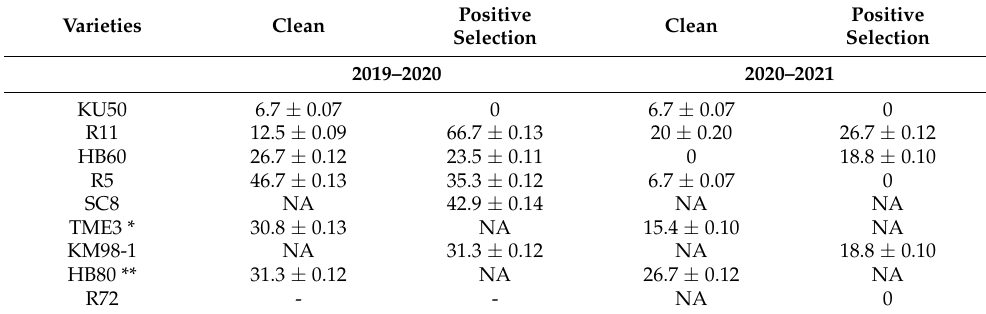
Table 4. Percentage of asymptomatic plants testing positive for Sri Lanka cassava mosaic virus (SLCMV) over 2 years. Young leaves from 33.3% of plants without any symptoms from each plot were collected for diagnosis of SLCMV by PCR of 9 varieties of cassava listed. Samples were collected 63 and 270 days after planting (DAP) during 2019–2020 season (year 2) and 21 DAP during 2020–2021 season (year 3). Positive Positive Varieties Clean Clean Selection Selection KU50